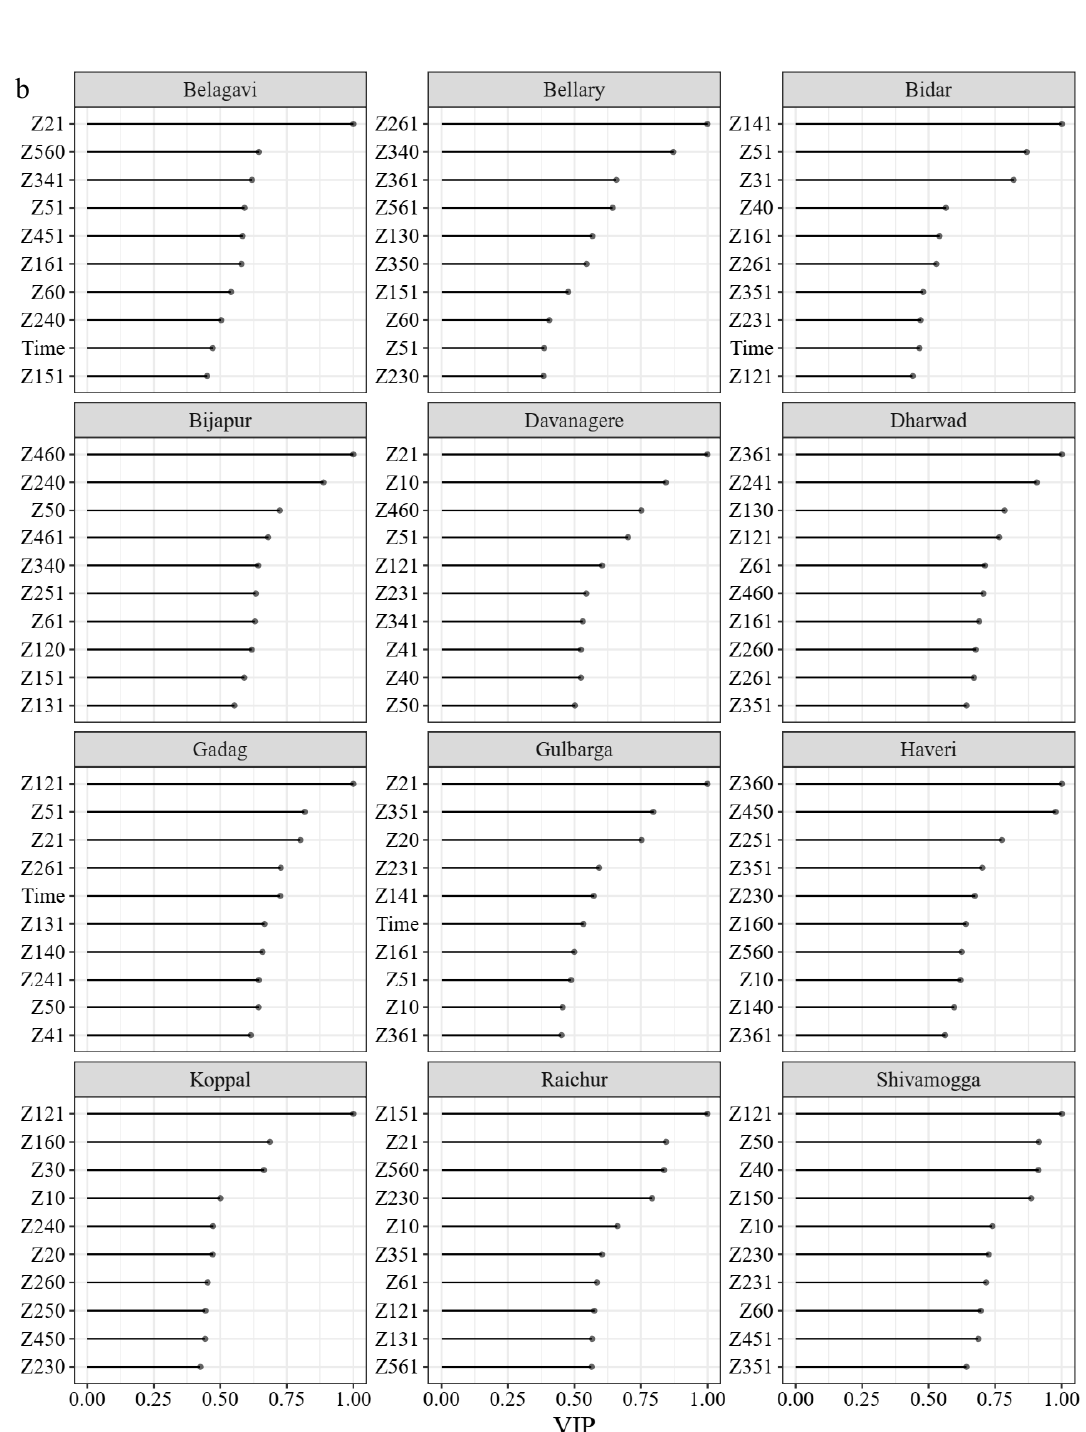
Figure 1. Variable importance of ANN (10 most important indices) model without ( a ) and with AET ( b ).